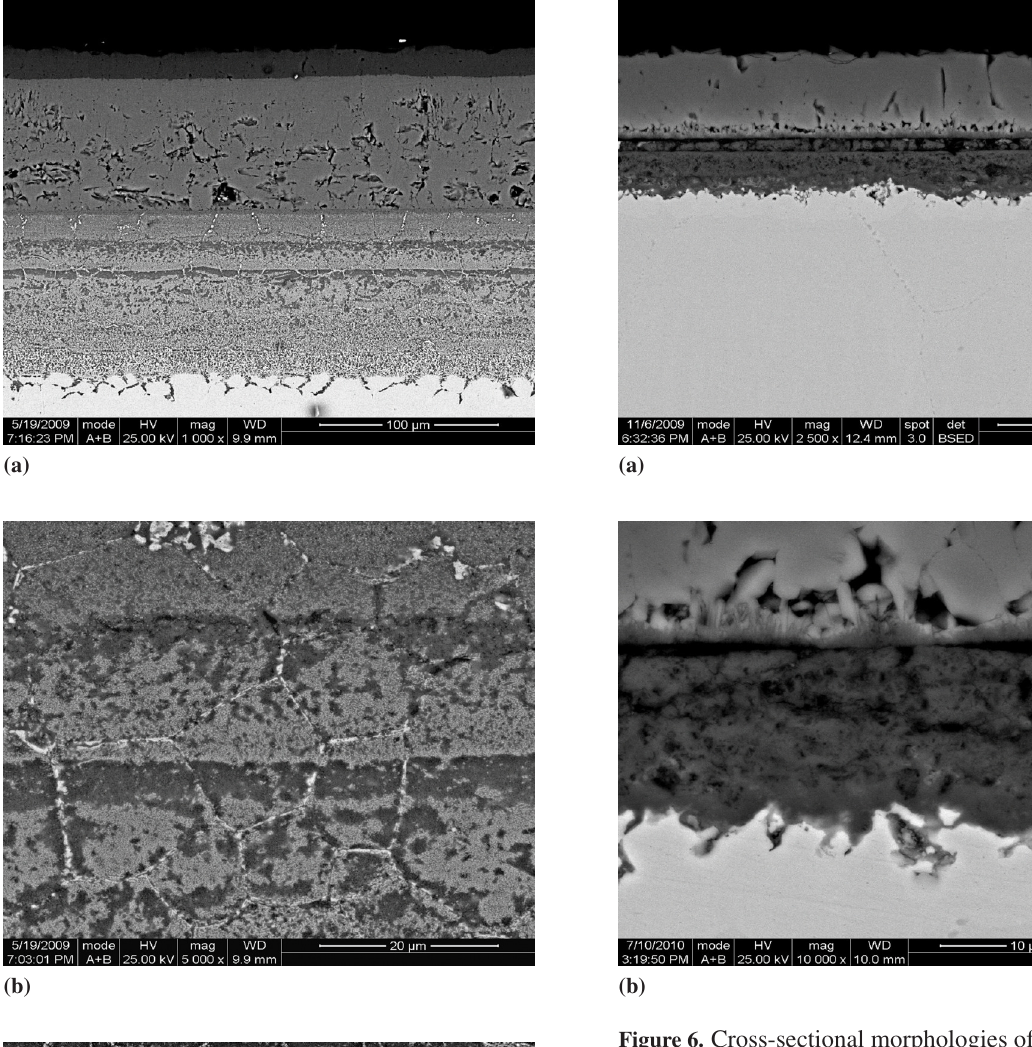
Figure 6. Cross-sectional morphologies of 310 SS corroded at 973 K in (Li,Na,K) 2 CO 3 for 500 h. (a) general view; (b) the amplified view of the inner layer of